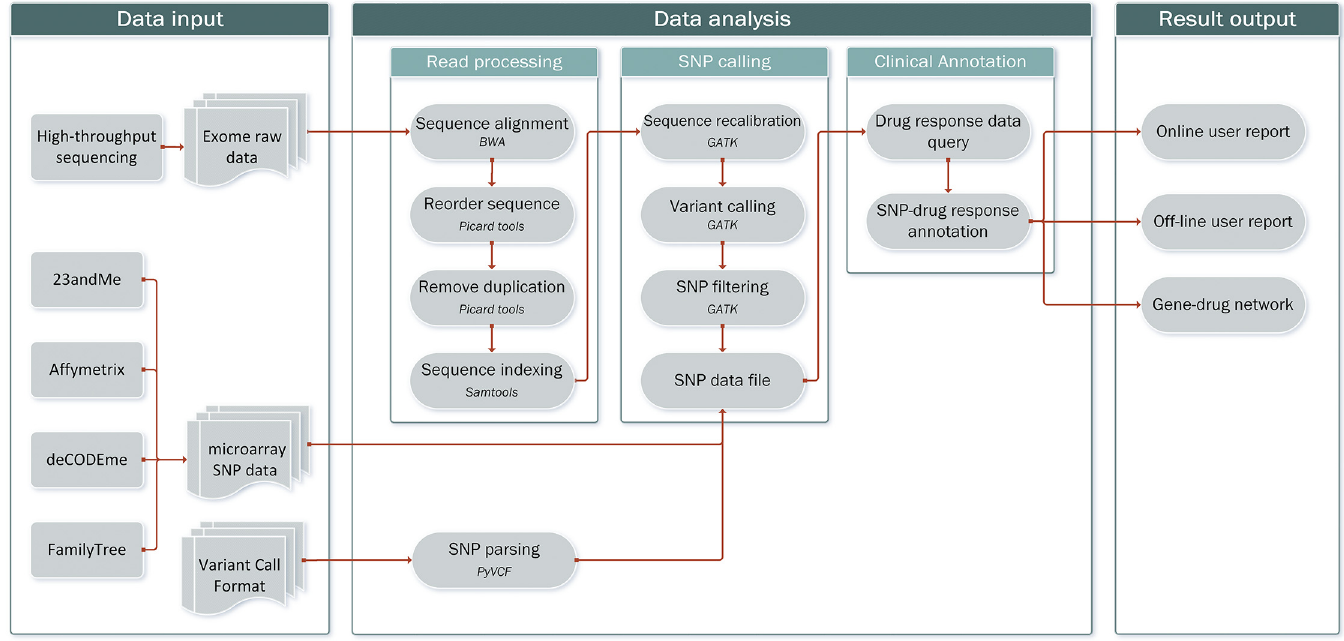
Fig 1. Schematic of the Virtual Pharmacist (VP) workflow. The three components of VP are